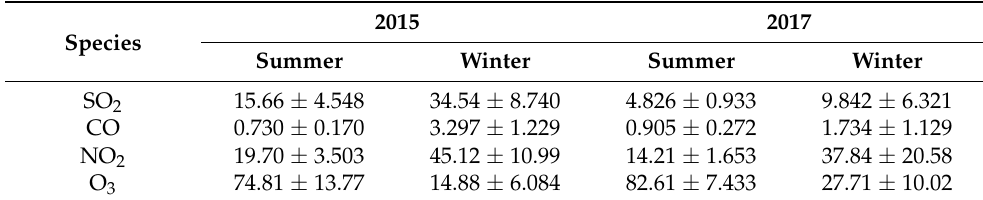
Table 3. The mean concentration and the standard deviation of gaseous pollutants during sampling (unit: